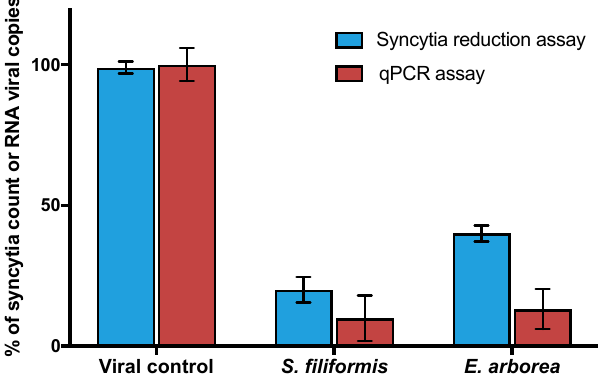
Figure 1. Antiviral activity of Ecklonia arborea and Solieria filiformis extracts. PPs were tested at 5 µg/mL by syncytia reduction and qPCR assays. Syncytia count and viral RNA copies number are given in % of the untreated control values. Each bar represents the average of three replicates.